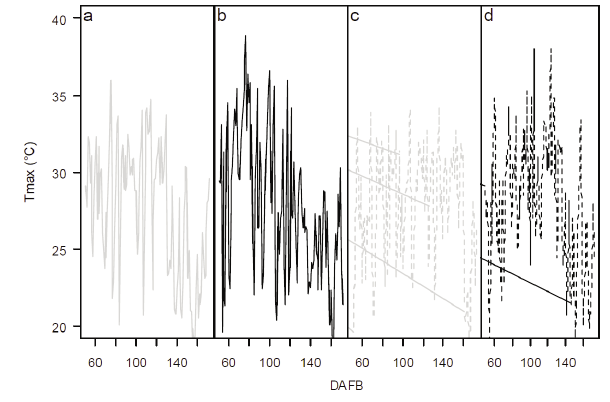
Fig. 3 ­ Air maximum temperature (Tmax) by days after full bloom (DAFB) for four production cycles. a. cycle 1; b. cycle 2; c. cycle 3; d. cycle 4.